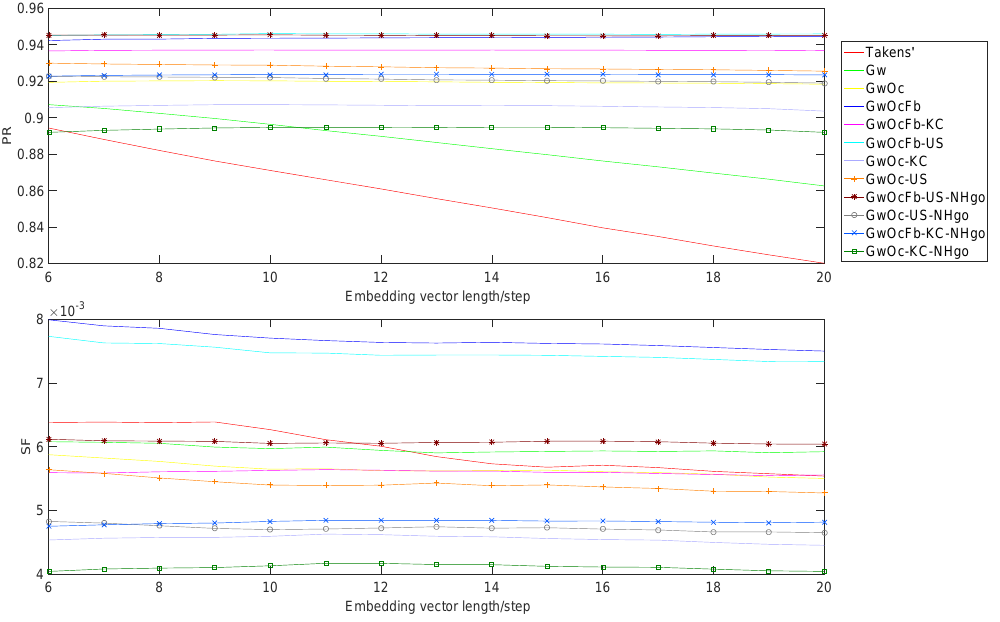
Figure 9. Influence of embedding vector length (left hip joint data in the sagittal plane). As shown in Figure 10, when the weighted best matching vector number increased, the PR s of different methods rose to the highest at 5 and the trend then descended afterwards. Meanwhile, for the FS s after 5, they also entered an slow falling state. This was reasonable because the matched vector quality degraded when the number increased to a certain level, and their weighting values fell quickly. At the same time, the increasing number of weighted history embedding vectors worked as a smoother by averaging down the